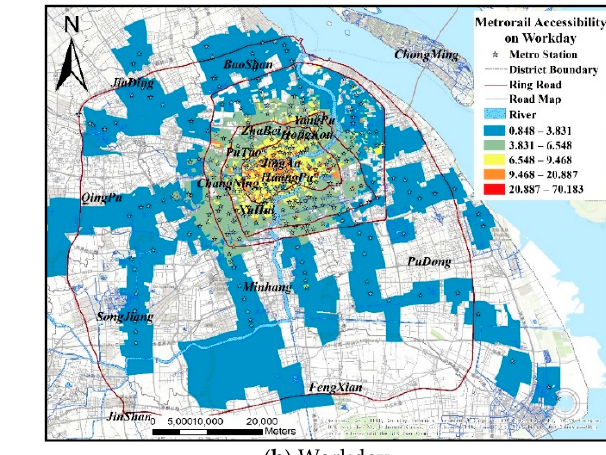
Figure 5. Distribution of transit accessibility by station.